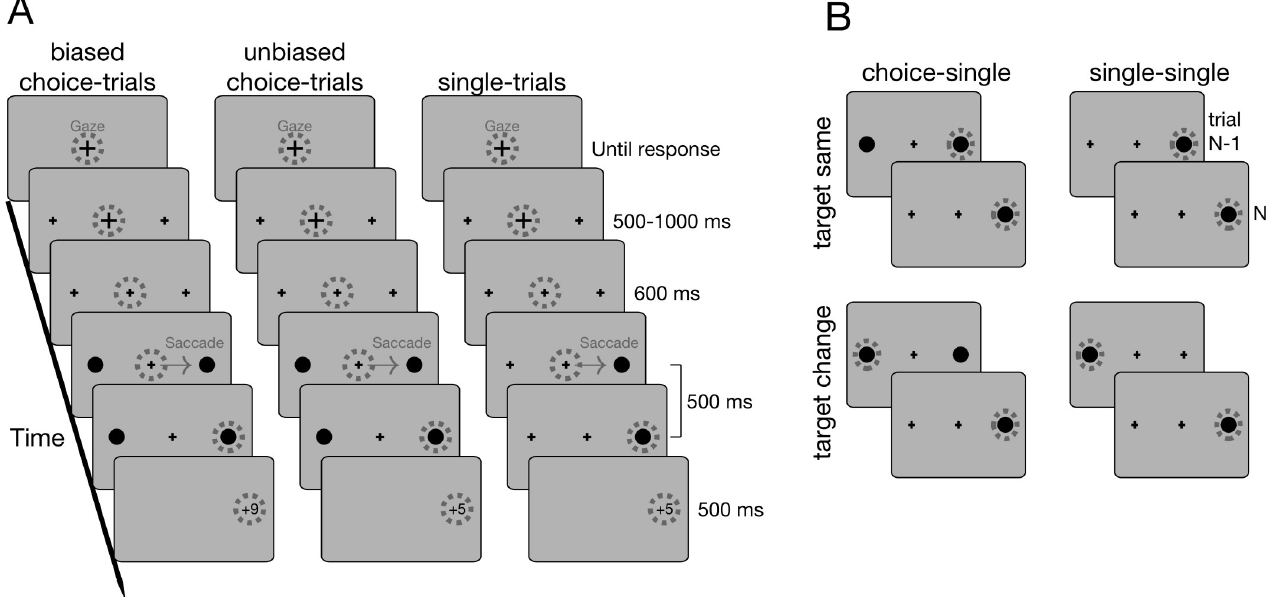
Fig 1. (A) Trial-procedure for biased and unbiased choice-trials as well as for single-trials. Biased and unbiased choice-trials differed with respect to the reward distribution across both target locations. In single-trials, only one target was displayed and reward was the same for both locations. One experimental block contained single-trials and either biased or unbiased choice-trials. (B) Inter-trial sequences. For a given single-trial, the previous trial could be a choice- or single-trial and it could imply a saccade to the same or the other target. To compute inter-trial effects, we subtracted single-trial latencies from choice-single sequences from the corresponding single-single sequence. Sequences were further split into trials from the biased and unbiased condition (not shown in figure). (A & B) Gray dashed circles denote gaze position and thus indicate which target was selected in choice-trials.